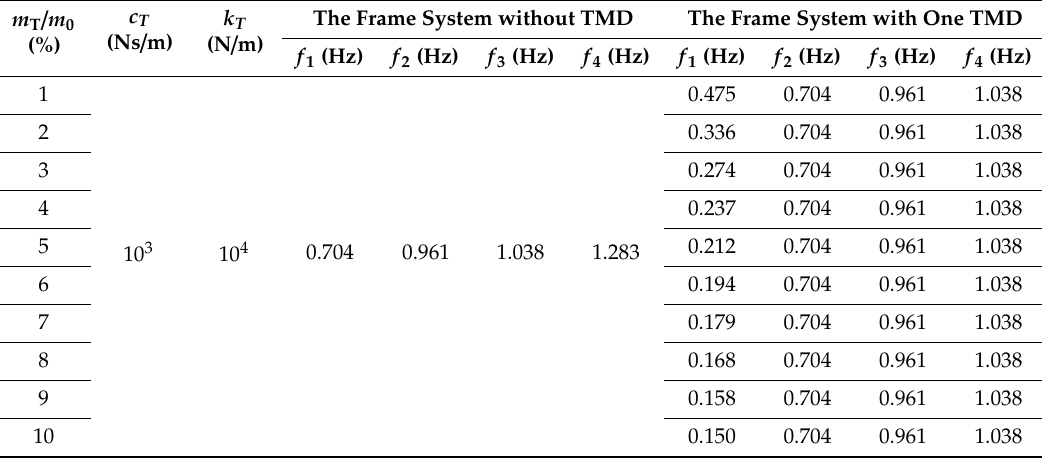
Table 8. Variation of the first natural frequencies of the space frame system as a function of m T / m 0 .